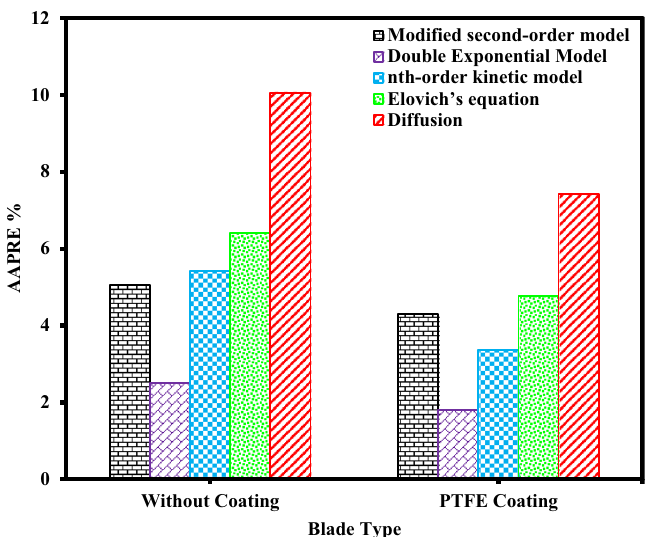
Figure 12. Comparison of deposition kinetics models for different coatings at concentration of 2000 ppm in dynamic state based on AAPRE.